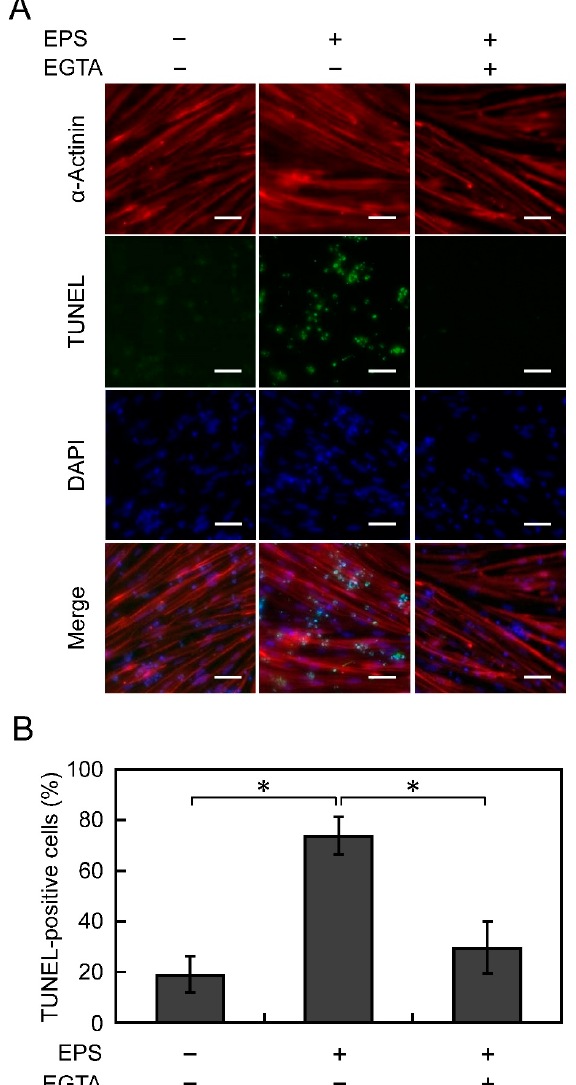
Figure 4. Effect of EGTA on apoptosis of D-iPS cell-derived myotubes. D-iPS cell-derived myotubes were cultured with or without electrical pulse stimulation (EPS) (0.30 V/mm) in the presence or absence of 1.0 mM EGTA. ( A ) Fluorescence microscopy of myotubes stained with anti- α -actinin antibody (red) and DAPI (blue). Apoptotic cells were stained by the TUNEL assay (green). Scale bars, 75 µm. ( B ) Quantitative analysis of the percentage of TUNEL-positive myotubes. Data are ex- pressed as the mean ± SD ( n = 3). * p < 0.05 vs without both EPS and EGTA (EPS–/EGTA–), or with both EPS and EGTA (EPS+/EGTA+).